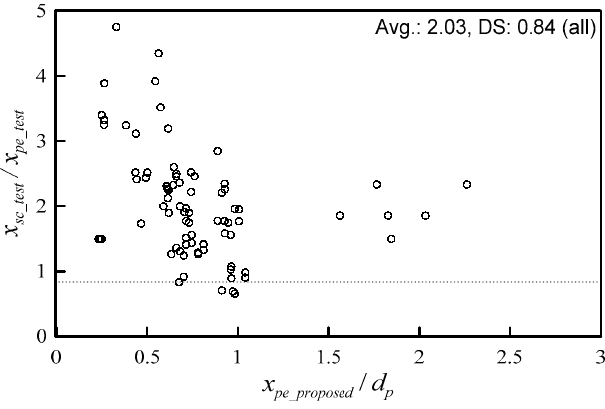
Figure 8. Ratio of tested penetration depth-to-scabbing depth.